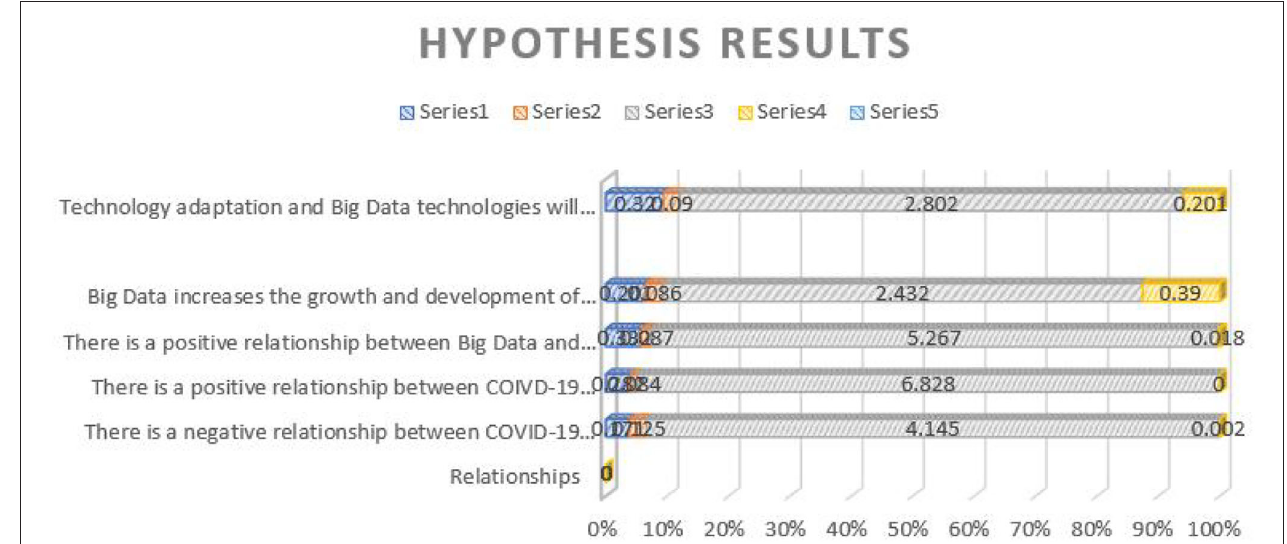
FIGURE 5 | Graphical representation of results of hypothesis testing ( X -axis, hypothesis testing results; Y -axis, hypothesis